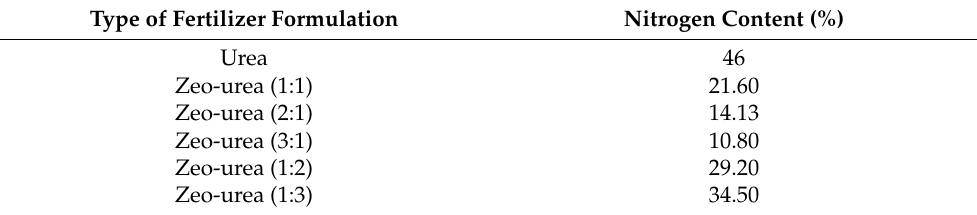
Table 2. Nitrogen content (%) in zeolitic